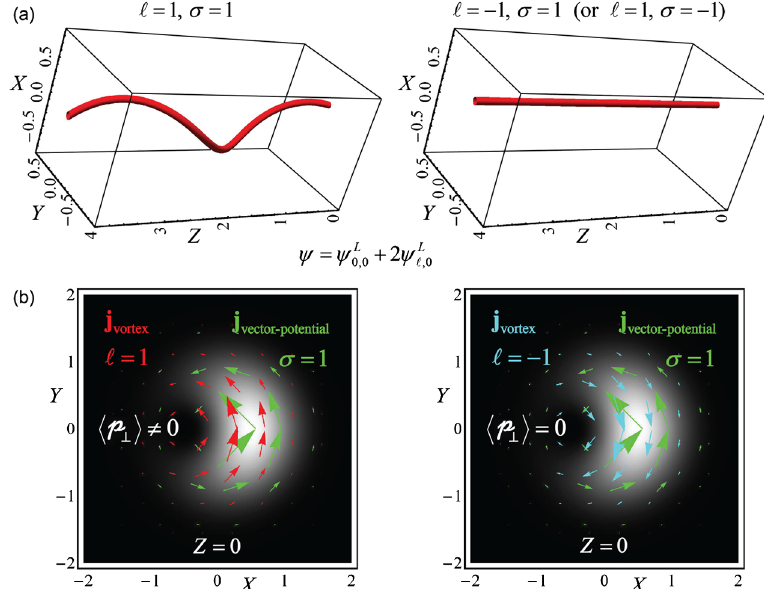
FIG. 9. (a) Trajectories of the centroids of superpositions (40) with ‘ ¼ 1 and ‘ ¼ (cid:1) 1 in a magnetic field with (cid:8) ¼ 1 . These trajectories satisfy the classical equations of motion (42) and correspond to evolutions shown in the upper panels of Figs. 7 and 8. ¼ ð @ =m Þ Im ð c (cid:4) r c Þ and j ¼ (cid:1)ð e=m Þ A (cid:1) , (b) Transverse distributions of the probability densities (cid:1) and currents j vortex vector - potential þ j ¼ j , Eq. (15). In the cases ‘(cid:8) > 0 ( ‘(cid:8) < 0 ), the addition (cancellation) of the vortex and vector-potential where j vortex vector - potential i (cid:1) 0 ( h p i ¼ 0 ). These facts explain the cyclotron orbiting and currents yields a nonzero (vanishing) transverse momentum h p ? ? rectilinear propagation of the superpositions with ‘(cid:8) > 0 and ‘(cid:8) < 0 ,